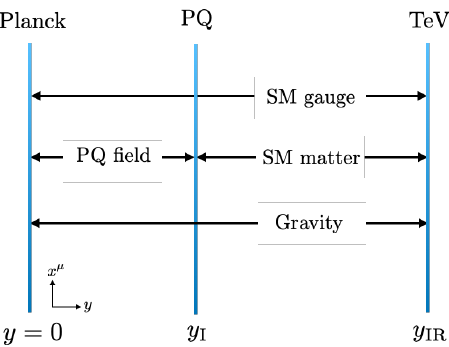
Figure 6 . The three 3-brane model to realize a natural and high-quality axion solution to the strong CP problem. The typical mass scales of the UV, intermediate and IR branes are identified as the Planck, PQ breaking and TeV scales. The U(1) PQ gauge field and a PQ breaking scalar field live in the bulk subregion between the Planck and PQ branes while the SM fields live in the other subregion between the PQ and TeV branes. A pair of KSVZ (anti-)quarks charged under the U(1) PQ live on the intermediate brane. Gravity propagates in the whole bulk